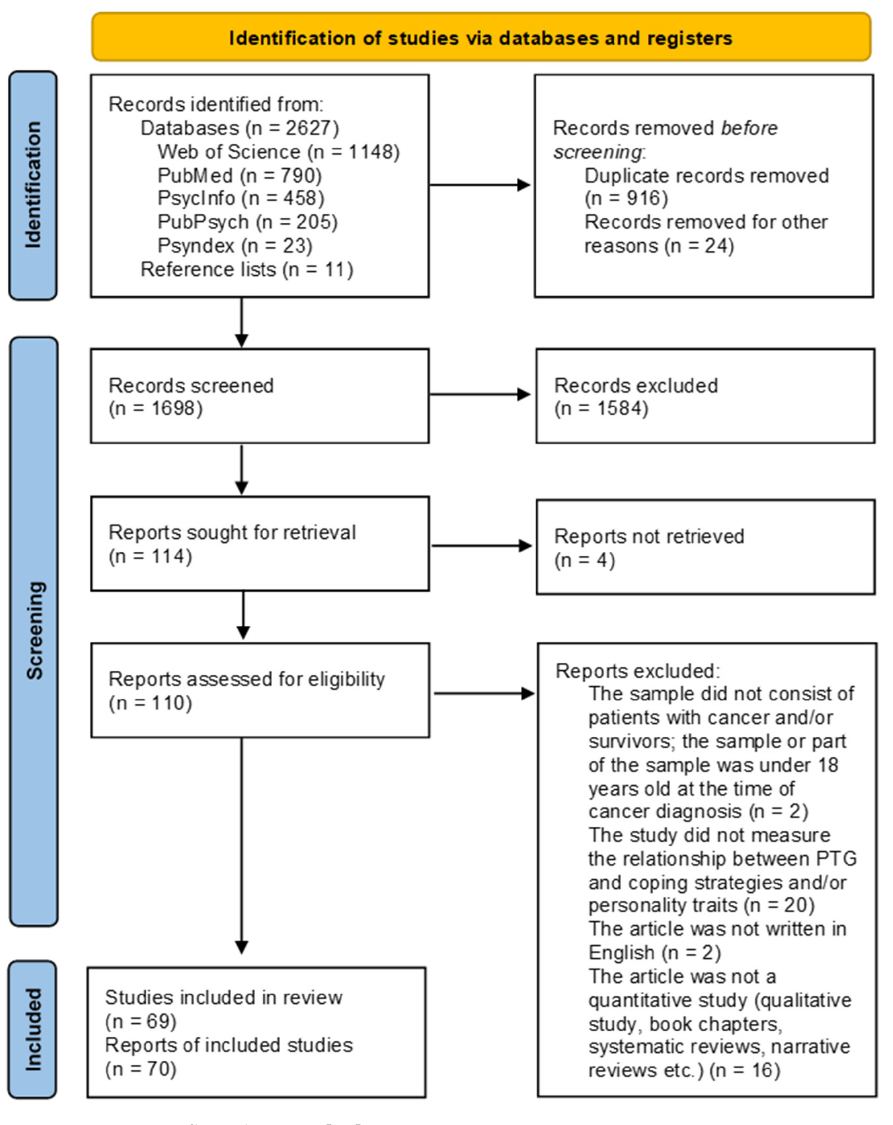
Figure 1. PRISMA flow diagram [32]. Table 1. Sample and study